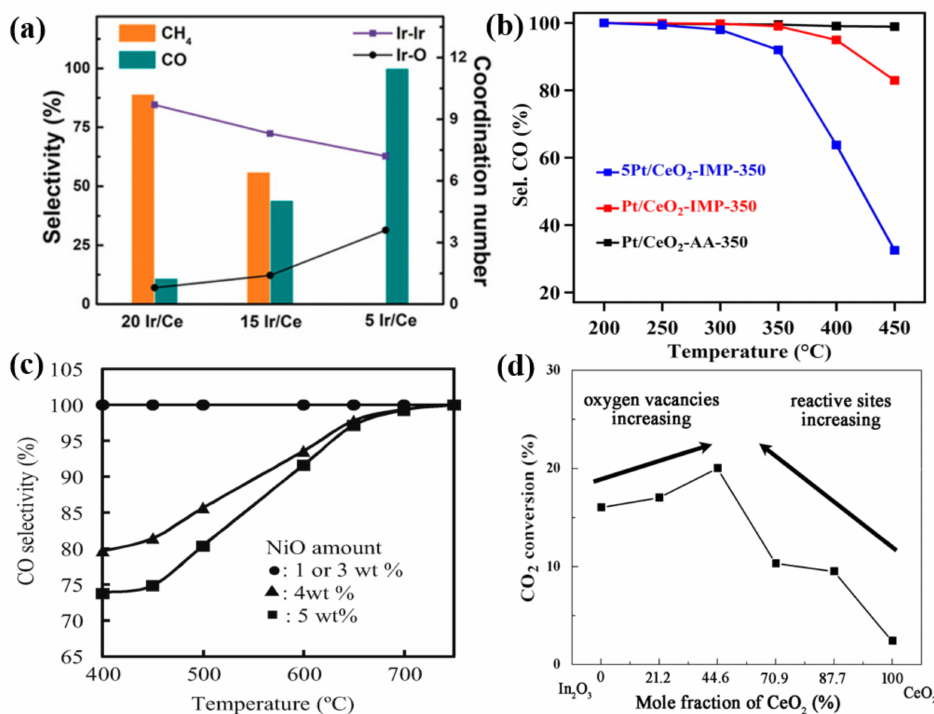
Figure 15. Effect of metal size CeO 2 support on RWGS reaction: ( a ) Ir-CeO 2 , reprinted with permission from [161], Copyright Wiley, 2017, ( b ) Pt-CeO 2 , reprinted with permission from [163]. Copyright Elsevier, 2021, ( c ) NiO-CeO 2 , reprinted with permission from [53]. Copyright Elsevier, 2014, ( d ) In 2 O 3 – CeO 2 , reprinted with permission from [164]. Copyright Elsevier,